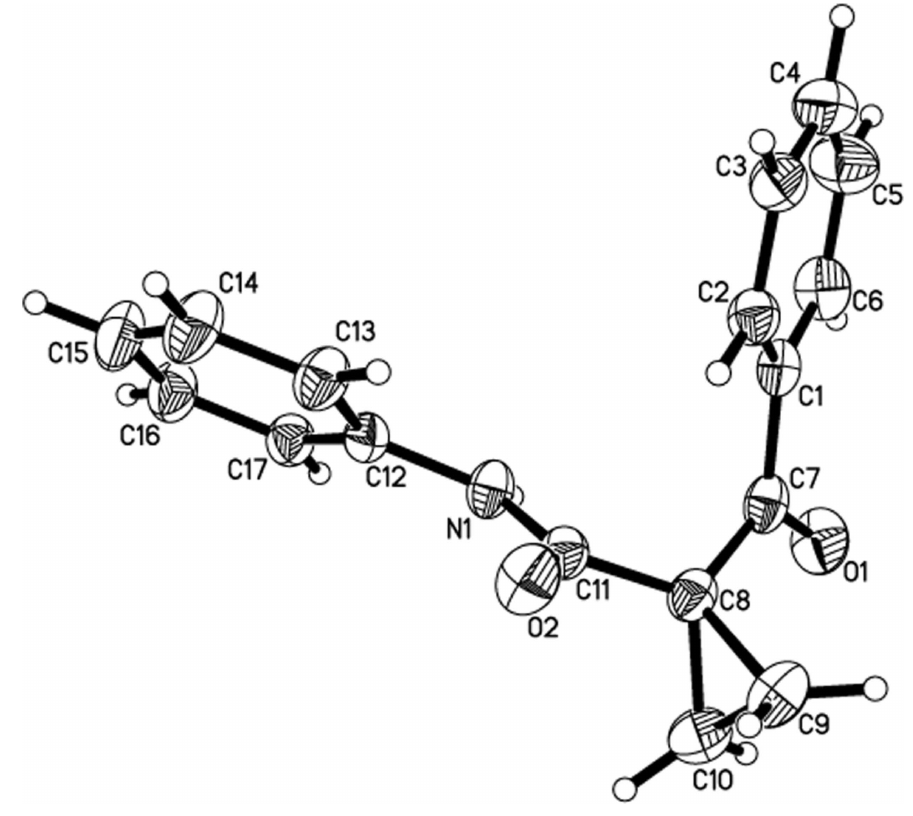
Molecular structure of the title compound with displacement ellipsoids drawn at the 30% probability level for non-H